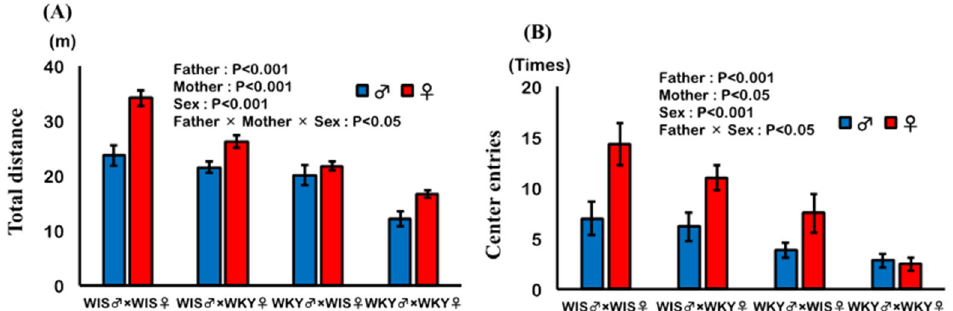
Figure 1. Effect of paternal or maternal strain on body weight of offspring. Body weight in the male ( A ) and female ( B ) pups was examined every 3 days and expressed as means ± SEM. Here, NS = not significant. Days refer to postnatal day after delivery/birth; WIS ♂ × WKY ♀ refers to pups of male Wistar (WIS) and female Wistar Kyoto (WKY) rats ( n = 6).